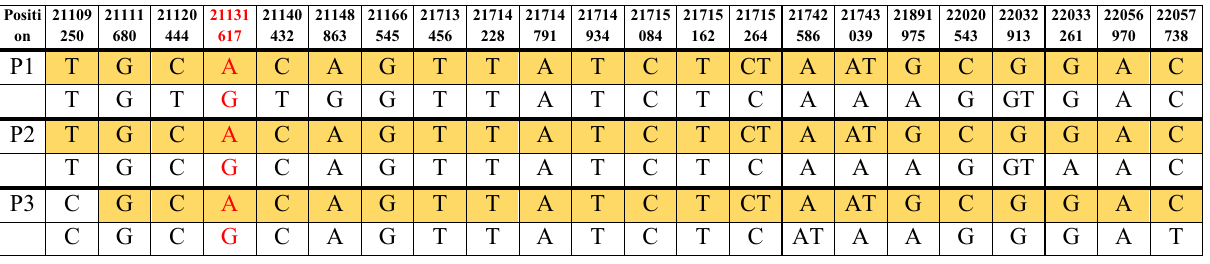
Table 2. Haplotypes of individuals with the P543L variant (in